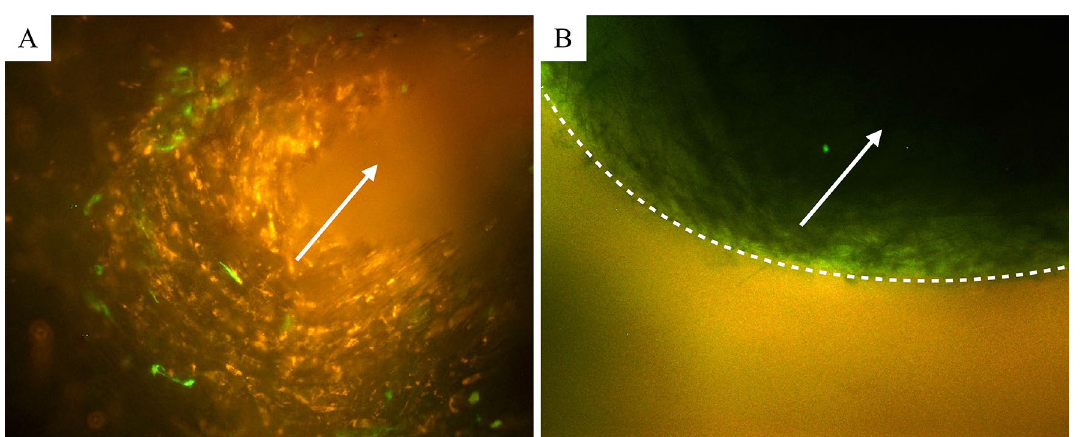
Figure 8. Cross sections of three-layer blood vessels. ( A ) 5 ml/min composite of 20 images with different focal planes from the front to the back of the freshly formed tissue. ( B ) 1 ml/min higher magnification image with wall exposure, white dotted line: defined separation of two layers. Both; red: RFP-SMC, green: GFP-HUVEC, white arrow: flow